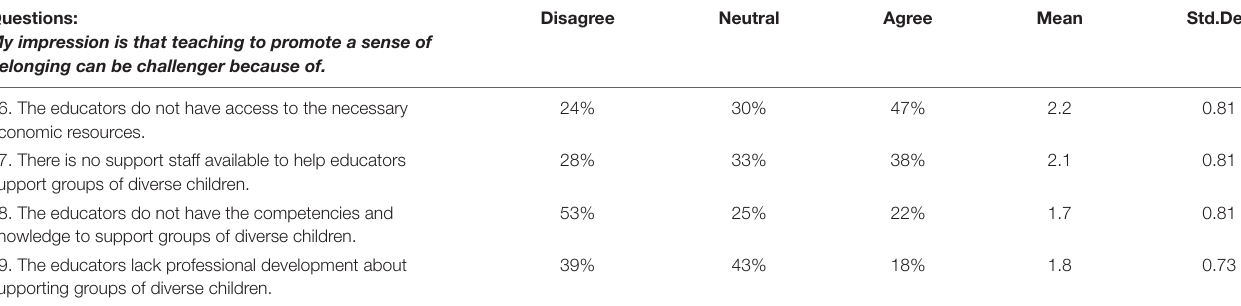
TABLE 10 | Scale 5: Resources to meet children with